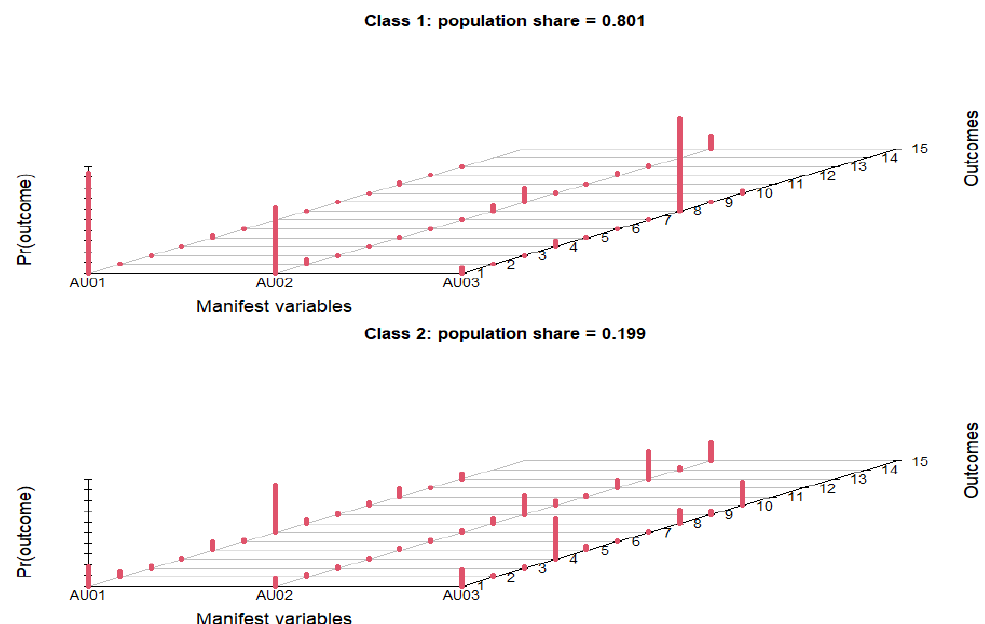
Figure 3. Respondents’ antibiotic use practices.